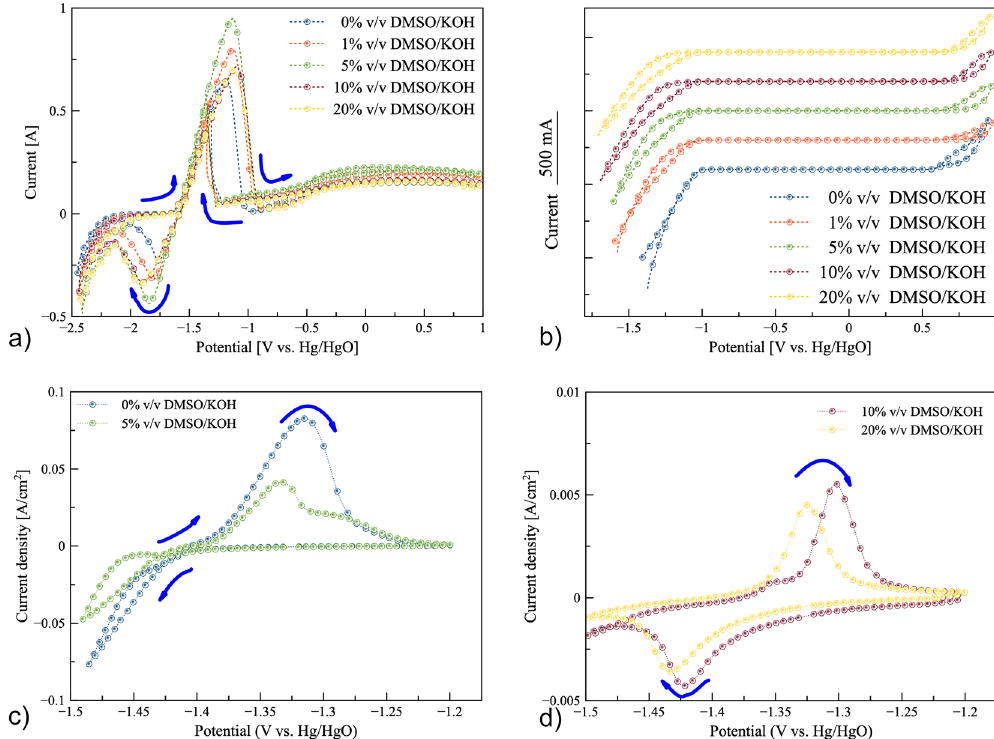
Figure 2. Cyclic voltammograms: ( a ) zinc electrode in (0–20)% v/v DMSO/KOH electrolytes at a scan rate of 0.05 V/s, ( b ) electrochemical windows in (0–20)% v/v DMSO/KOH electrolytes, ( c ) plating/stripping of zinc on Pt electrode in 0 and 5% v/v DMSO/KOH electrolytes at a scan rate of 0.025 V/s, and ( d ) plating/stripping of zinc on a Pt electrode in 10 and 20% v/v DMSO/KOH electrolytes at a scan rate of 0.025